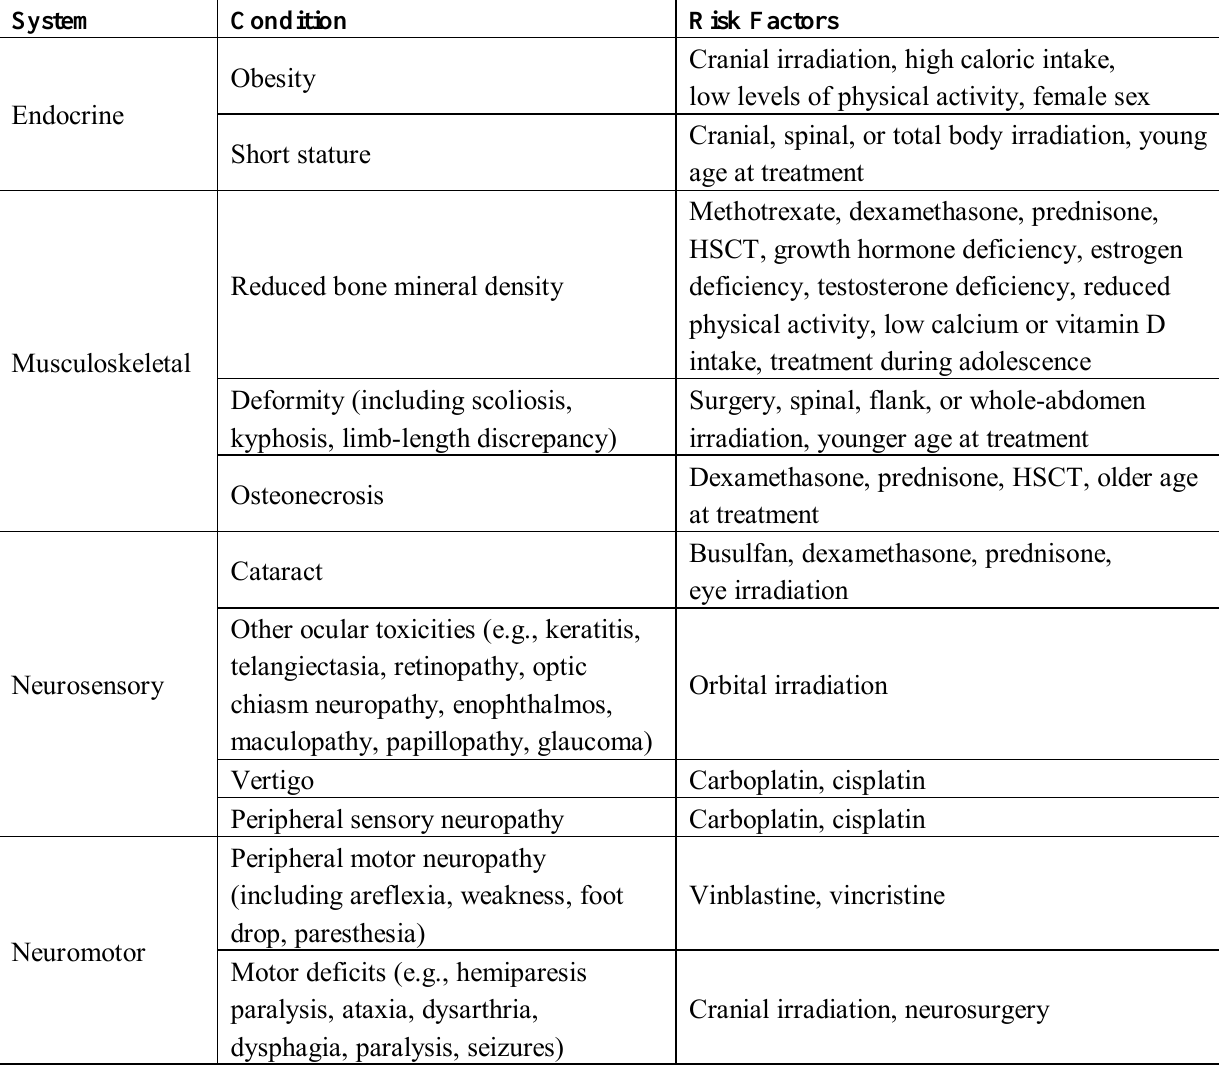
Table 1. Acute and late effects among survivors of childhood